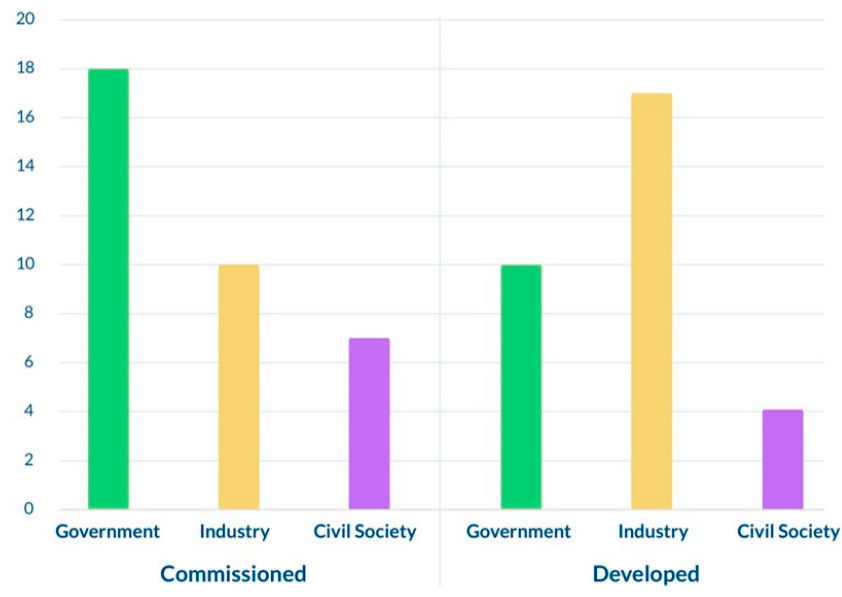
Figure 3. Actors commissioning and developing roadmaps (source: author’s own).